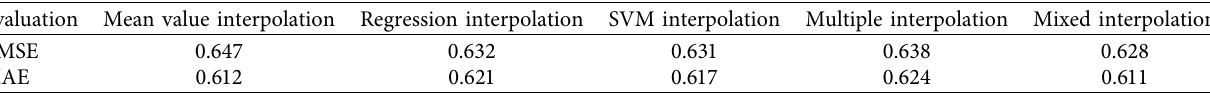
Figure 4: Missing data distribution map at 5% data missing rate. Table 1: Comparison of RMSE and MAE values of five interpolation